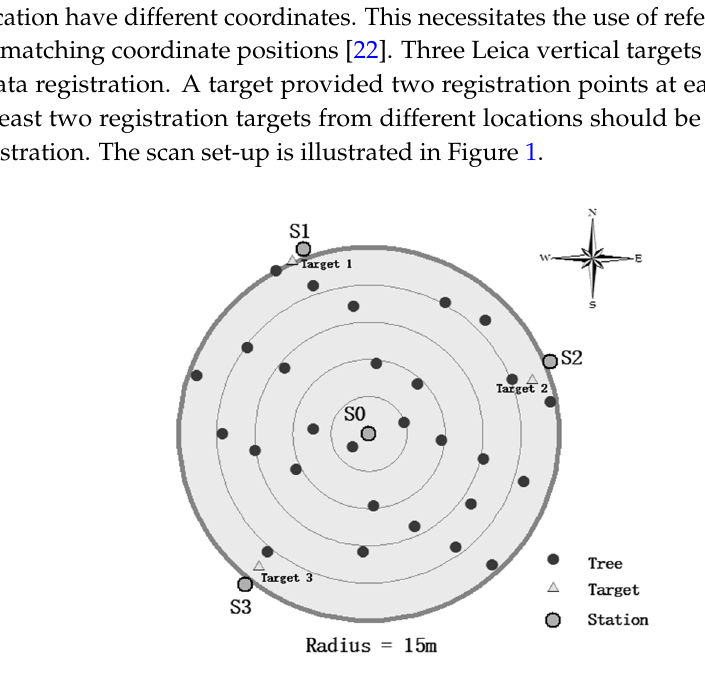
Figure 1. An illustration of tree stem, scanning stations, and reference target locations in a 15-m circular plot. S0 to S4 represent the four scanning locations, and the triangles show the three reference points.